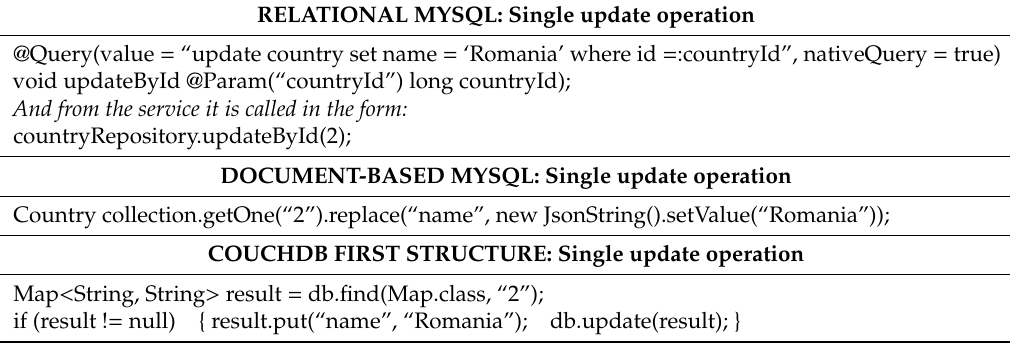
Table 2. Single update operations.